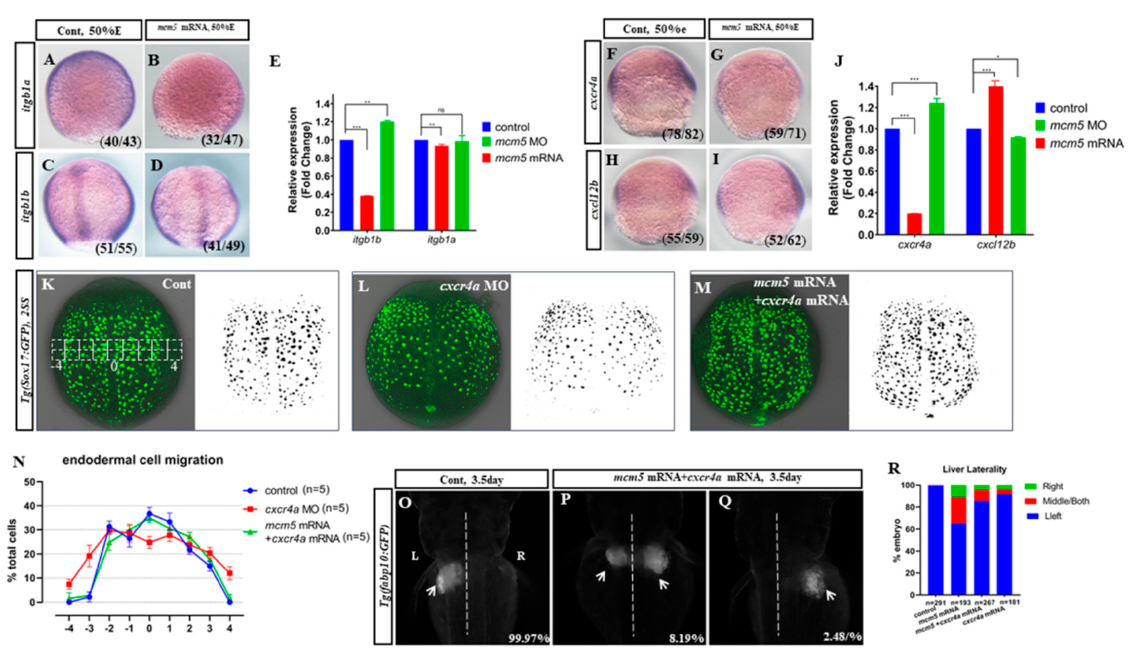
Figure 4. The downregulation of the Cxcr4a-itgb1b cascade slowed down endodermal migration in embryos injected with mcm5 mRNA. ( A – E ) Compared with that in control embryos ( A , C ), the expression of itgb1a and itgb1b was decreased in embryos injected with mcm5 mRNA ( B , D ). Quantitative PCR results showed that the expression level of itgb1a mRNA in embryos injected with mcm5 mRNA was 0.9-fold to that in the control ( E , p = 0.001), but it was no different in the mcm5 morphants or in the control ( E , 0.95-fold, p = 0.67). The itgb1b level in embryos injected with mcm5 mRNA was 0.38-fold to that in the control ( E , p = 0.001), while the level in mcm5 morphants was 1.20-fold to that in the control ( E , p = 0.03). (F-J) In embryos injected with mcm5 mRNA, the expression levels of cxcr4a and cxcl12b were decreased ( F , G ) and increased ( H , I ), respectively. Quantitative PCR indicated that the expression levels of cxcr4a and cxcl12b in embryos injected with mcm5 mRNA were also downregulated ( J , 0.19-fold relative to the control, p = 0.0009) and upregulated ( J , 1.35-fold relative to the control, p = 0.0002), respectively. In mcm5 morphants, the expression levels of cxcr4a and cxcl12b were upregulated ( J , 1.24-fold relative to the control, p = 0.0003) and downregulated ( J , 0.9-fold relative to the control, p = 0.02), respectively. ( K – M ) Compared with that in the control ( K , n = 25, 92%), GFP-labeled endodermal migration in cxcr4a morphants was slowed down ( L , n = 122, 88.5%, p < 0.01), but mcm5 mRNA and cxcr4a mRNA co-injection restored endodermal migration ( M , n = 98, 73.5%, p < 0.05). Quantitative analysis for the selected area (shown in K ) showed that migration of the delayed endodermal cells in the “ − 4” area and the “4” area in embryos injected with mcm5 mRNA was restored by co-injection with cxcr4a mRNA ( N , n = 5). ( O – R ) An injection of cxcr4a mRNA restored the liver location in embryos injected with mcm5 mRNA. An injection of cxcr4a mRNA (30 ng/µL or more) resulted in a small proportion of the embryos displaying liver bifida (R, last column shown, n = 181, p < 0.05). Co-injection with a low dose of cxcr4a mRNA (15 ng/µL) and mcm5 mRNA resulted in 10.1% and 4.7% of embryos displaying liver bifida and a right-sided liver, respectively ( P , Q ). Co-injection with cxcr4a mRNA and mcm5 mRNA restored the liver location phenotype in embryos injected with mcm5 mRNA ( R , columns 2 and 3, n = 267, p < 0.05).